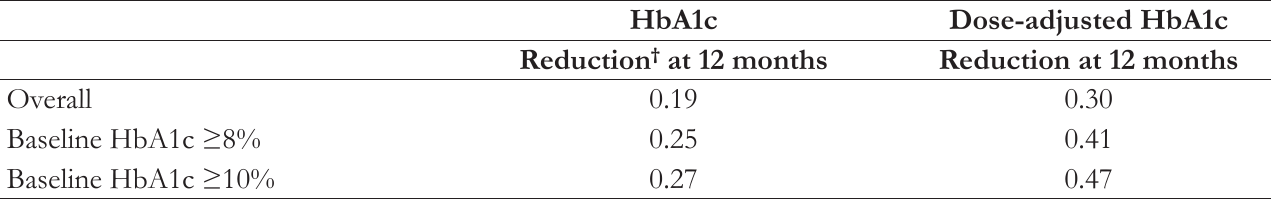
Table 2. Improvement in Glycaemic Control (HbA1c) at 12 months † for Glargine versus NPH; before and